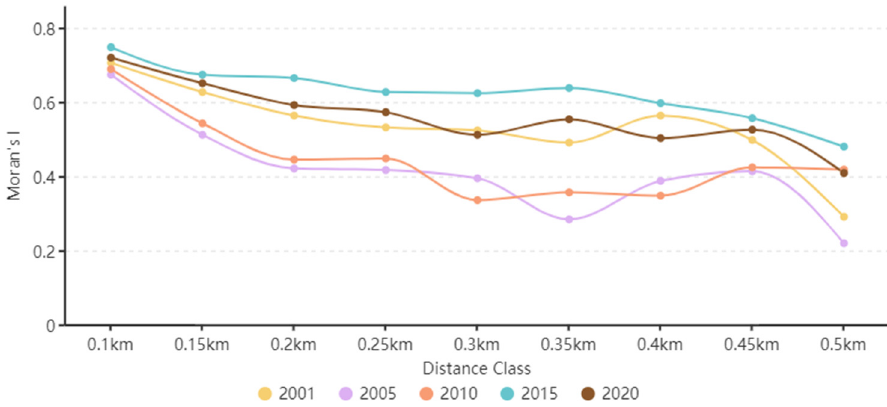
Figure 9. Moran’s I values for the ecological risk index (ERI) using different distances.